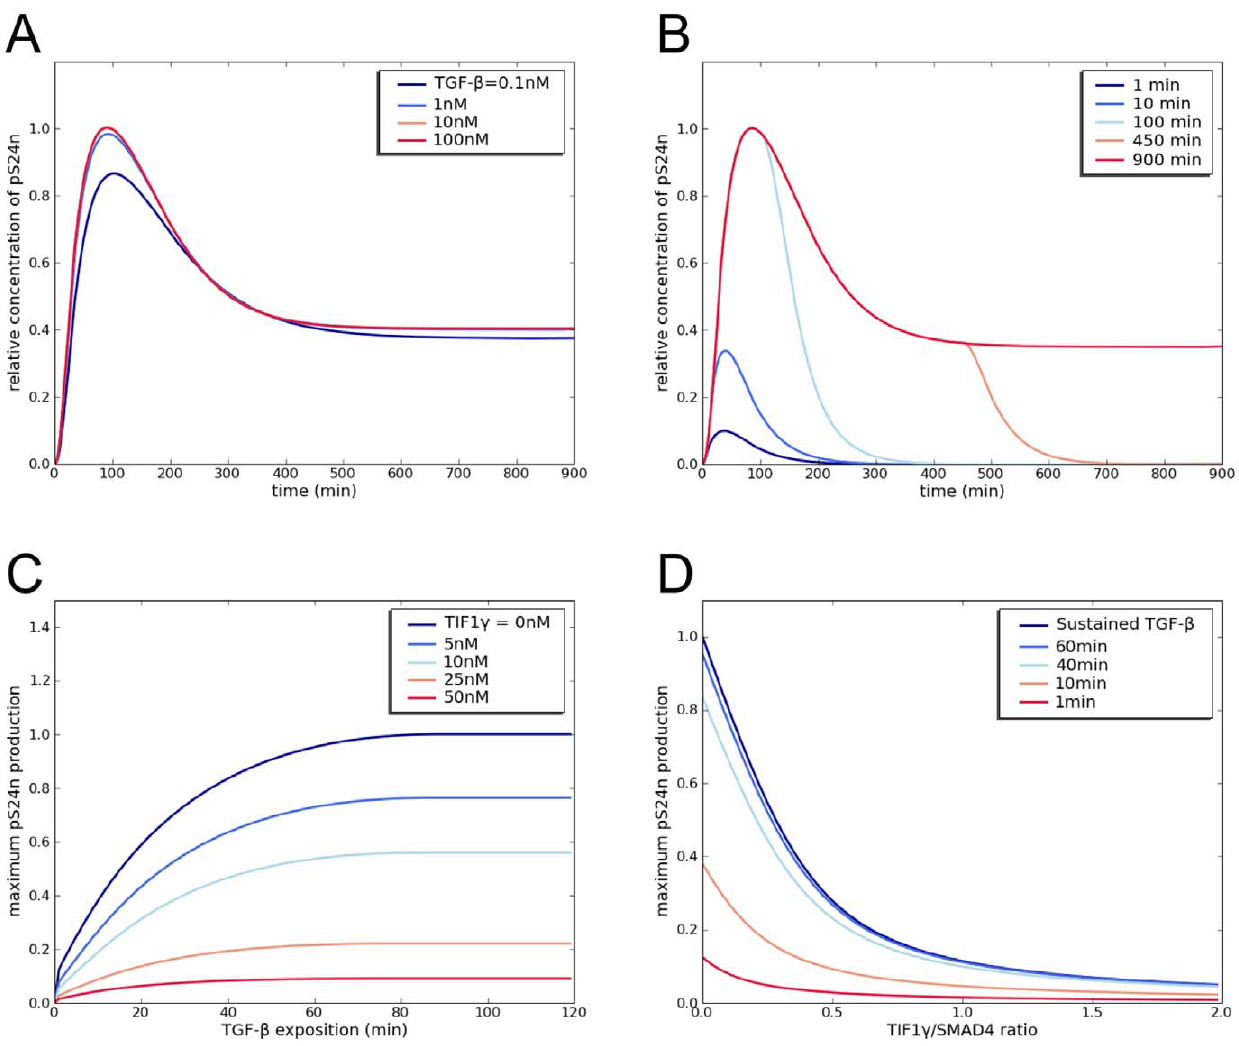
Figure 6. Concentration and time dependence of TGF- b signaling. A) and B) Modeling analysis of the pS24n response to increasing concentrations of TGF- b (A) and duration of stimulation with 10 nM TGF- b (B). C) and D) Modeling analysis of the maximum pS24n response as a function of TGF- b duration of exposure (C) or increasing TIF1 c /Smad4 ratios (D).